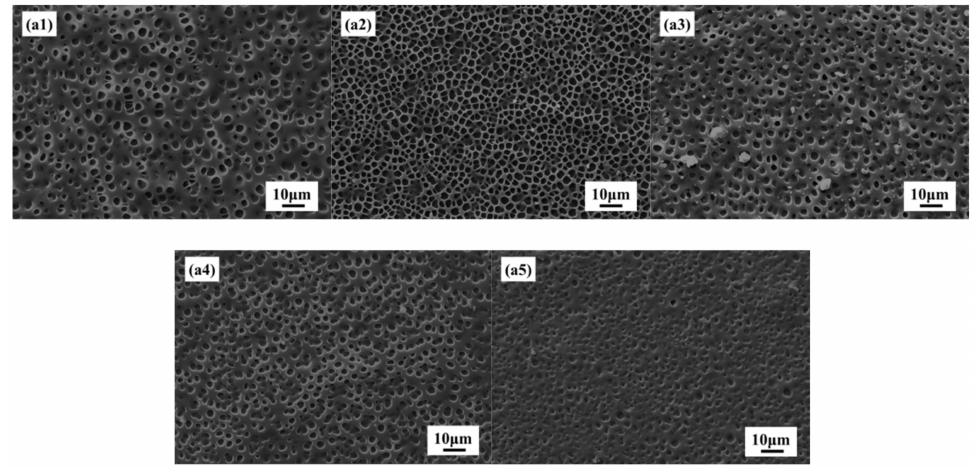
Figure 3. SEM images of ( a1 ) 0% 2-EHA; ( a2 ) 5% 2-EHA; ( a3 ) 10% 2-EHA; ( a4 ) 15% 2-EHA; ( a5 ) 20%